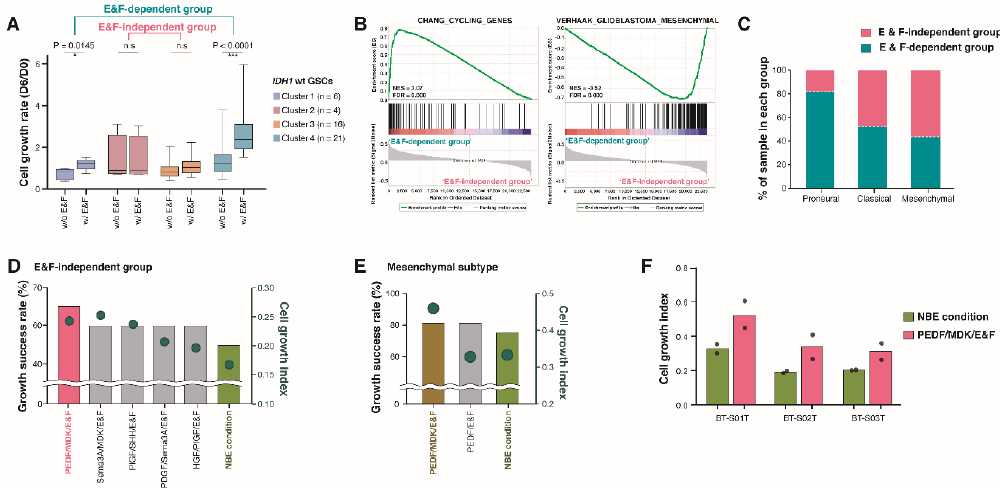
Figure 4. Identification of new culture conditions in E&F-independent GSCs among IDH1 -wt GSCs. ( A ) The 6-day cell proliferation rates of each cluster without or with E&F. The E&F-dependent group differed significantly in 6-day cell growth rates according to whether E&F were present (Clusters 1 and 4, p = 0.0145 and p < 0.0001, respectively), while E&F-independent 6-day cell growth rates were not affected by the absence of E&F (Clusters 2 and 3). ( B ) The enrichment of a cell cycle-associated gene set (KONG_E2F3_TARGETS, the left panel) in E&F-dependent group and enrichment of a glioblastoma mesenchymal gene set (VERHAAK_GLIOBLASTOMA_MESENCHYMAL, the right panel) in the E&F-independent group. ( C ) The distribution of glioblastoma subtypes into independent and dependent groups in IDH1 -wt DIGs. ( D – E ) The culture conditions with higher growth success rates than the NBE condition for E&F-independent group ( D ) and mesenchymal IDH1 -wt GSCs ( E ). The bars and dots indicate growth success rates and cell growth indices, respectively. ( F ) The cell growth indices of IDH1- wt GSCs from a validation cohort under epidermal growth factor (EGF) and basic fibroblast growth factor (bFGF) (E&F; referred to as NBE) and pigment epithelium-derived factor (PEDF)/midkine (MDK)/E&F conditions. The dots represent the values from technical